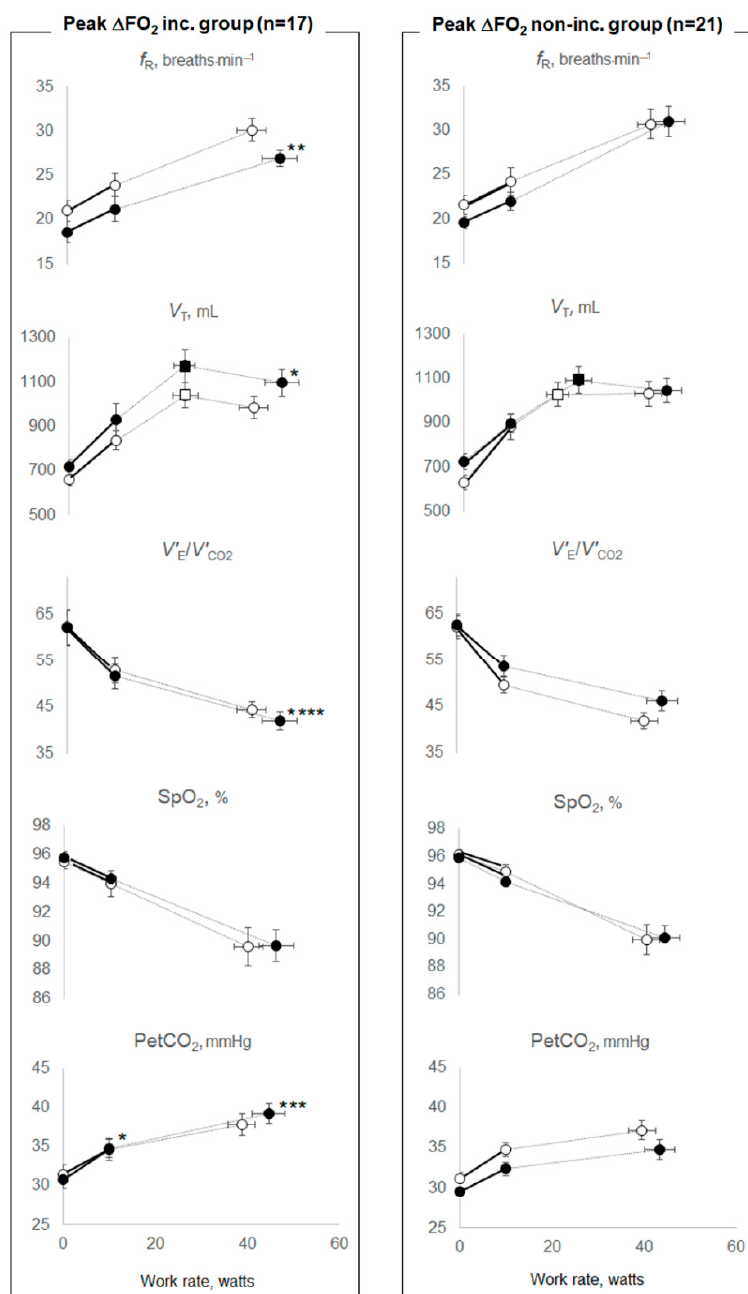
Figure 1. Exercise variables before and after pulmonary rehabilitation between the peak ∆ FO 2 increase and non-increase groups. Data are presented as means (standard error). All patients were divided into two groups based on whether or not ∆ FO 2 at peak exercise had increased after pulmonary rehabilitation. Peak ∆ FO 2 : difference between inspiratory and expiratory O 2 concentrations at peak exercise; inc.: increase; f R : breathing frequency; V T : tidal volume; V’ E : minute ventilation; V’ CO2 : carbon dioxide output; SpO 2 : percutaneous oxygen saturation; PetCO 2 : partial pressure of end-tidal carbon dioxide. * p < 0.05, ** p < 0.01, *** p < 0.001, **** p < 0.0001: mean differences between pre-and post-pulmonary rehabilitation values at each exercise phase were compared between peak ∆ FO 2 increase and non-increase groups. Open symbols: before pulmonary rehabilitation. Closed symbols: after pulmonary rehabilitation. Squares represent V T –ventilation inflection points.